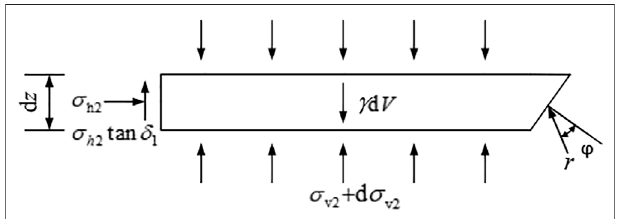
FIGURE 7 | Microelement mechanical model of Zone II.